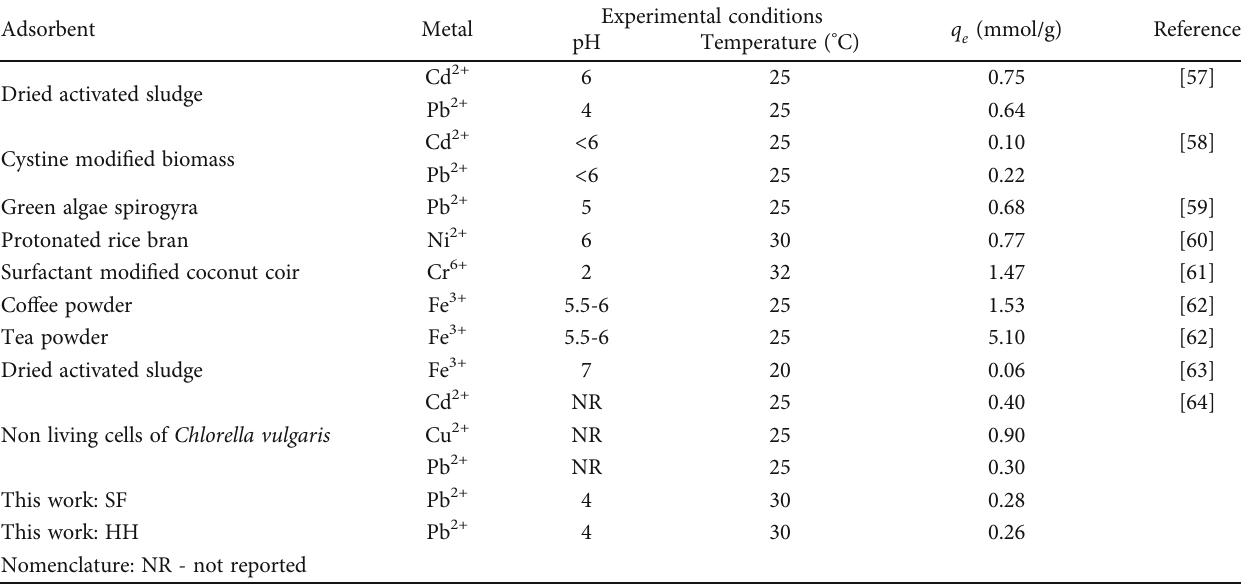
Table 5: Adsorption capacities of di ff erent materials reported for the heavy metal removal.